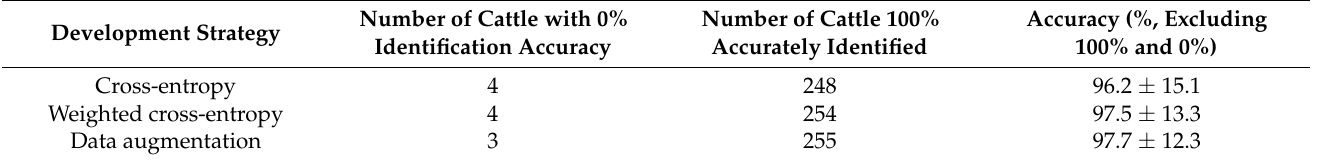
Figure 5. A ridgeline chart illustrating the probabilities of identification accuracy for individual cattle using ( top ) VGG16_BN without class imbalance optimization, ( middle ) VGG19_BN with weighted cross-entropy loss function, and ( bottom ) VGG16_BN with data augmentation. Table 6. Accuracy and processing speed before and after optimization for class imbalance.